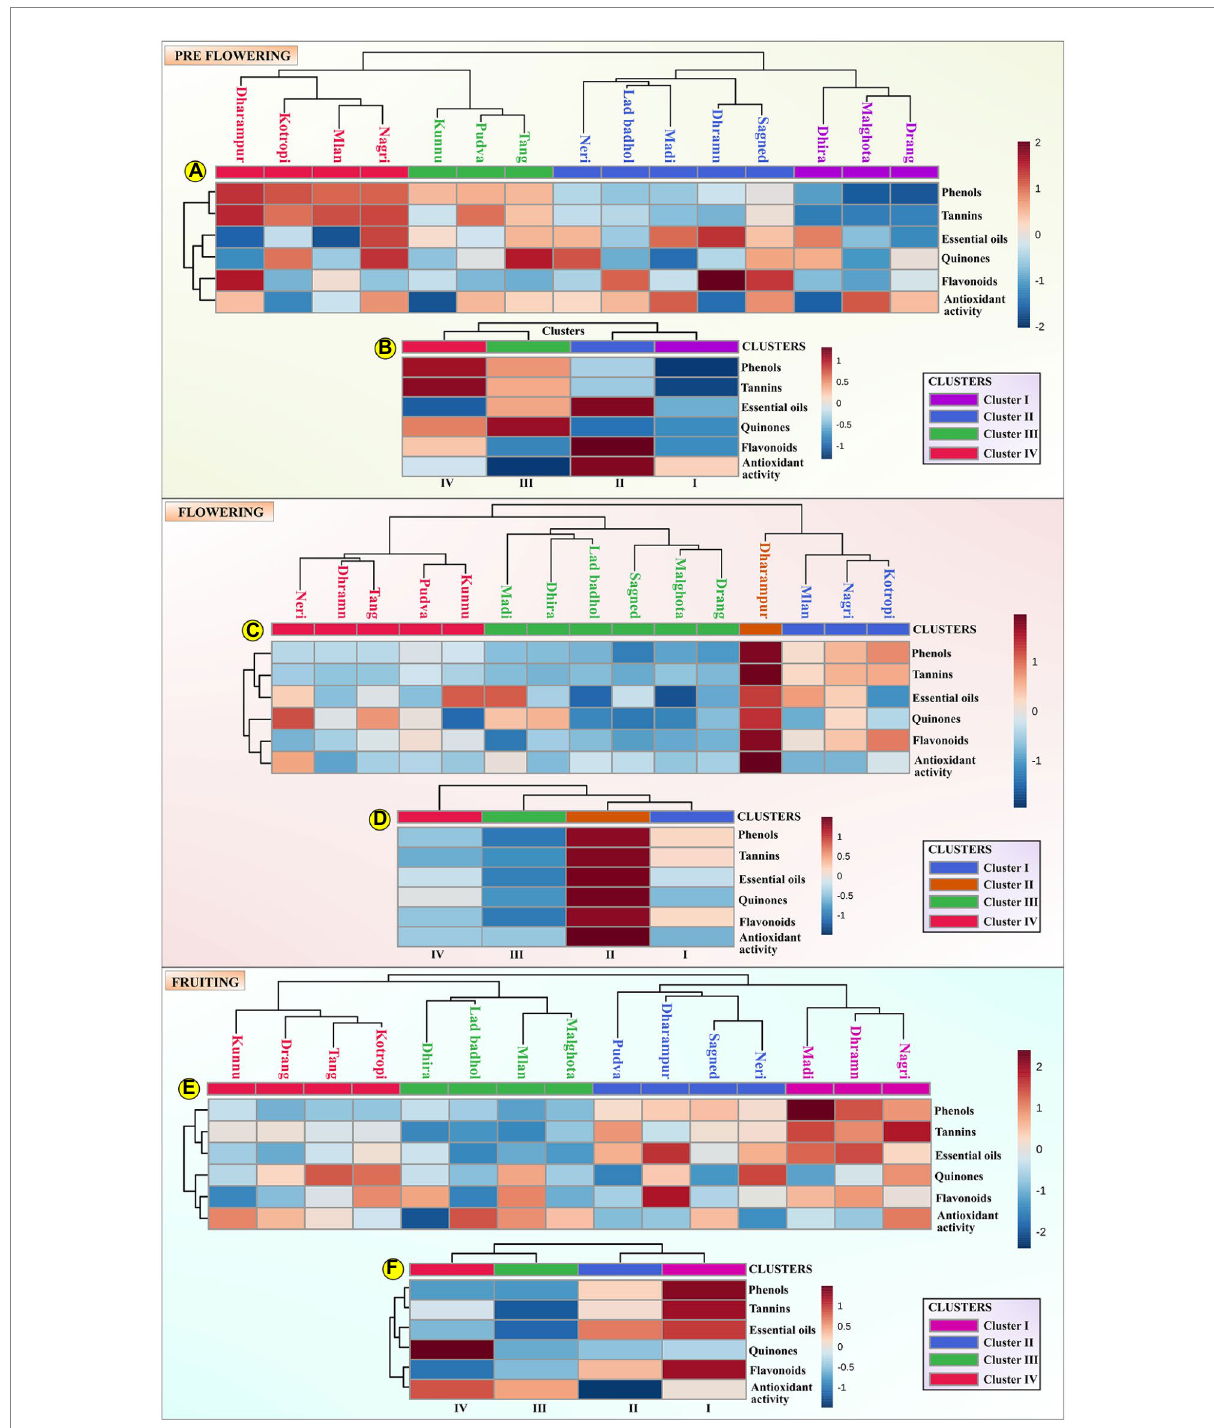
FIGURE 2 The assessed samples were organized into four different clusters, depicting their hierarchy and presented as a dendrogram and scaled phytochemical attributes are represented through a heat map. (A) represents the hierarchical cluster integrated with a heat map representing the scaled phytochemical attributes for each sample at the pre-flowering stage. The data is scaled between +2 and − 2; (B) represents the hierarchical cluster integrated with a heat map representing the mean scaled value of each cluster at the pre-flowering stage. The data is scaled between +1 and –1; (C) represents the hierarchical cluster integrated with a heat map representing the scaled phytochemical attributes for each sample at the flowering stage. The data is scaled between +1 and − 1; (D) represents the hierarchical cluster integrated with a heat map representing the mean scaled value of each cluster at the flowering stage. The data is scaled between +1 and − 1; (E) represents the hierarchical cluster integrated with a heat map representing the scaled phytochemical attributes for each sample at the fruiting stage. The data is scaled between +2 and − 2; (F) represents the hierarchical cluster integrated with a heat map representing the mean scaled value of each cluster at the fruiting stage. The data is scaled between +1 and −